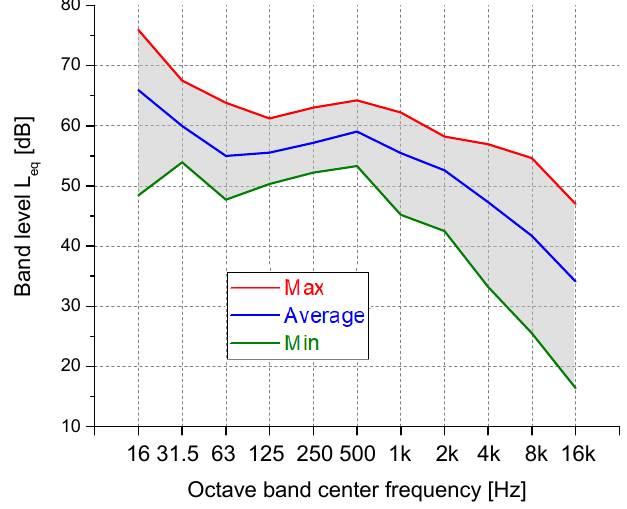
Figure 3. Range (grey area) of the mean octave band spectrum observed in the wards. The time variability of the sound level can be evaluated by the noise climate, computed to the difference L A10 –L A90 . Moreover, for this metric, a large variability was observed, from 3.4 to 18.5 dB(A) across the wards, with a maximum value in the surgery room. The box plots in Figure 4 show the large variability of the psychoacoustic metrics observed in the